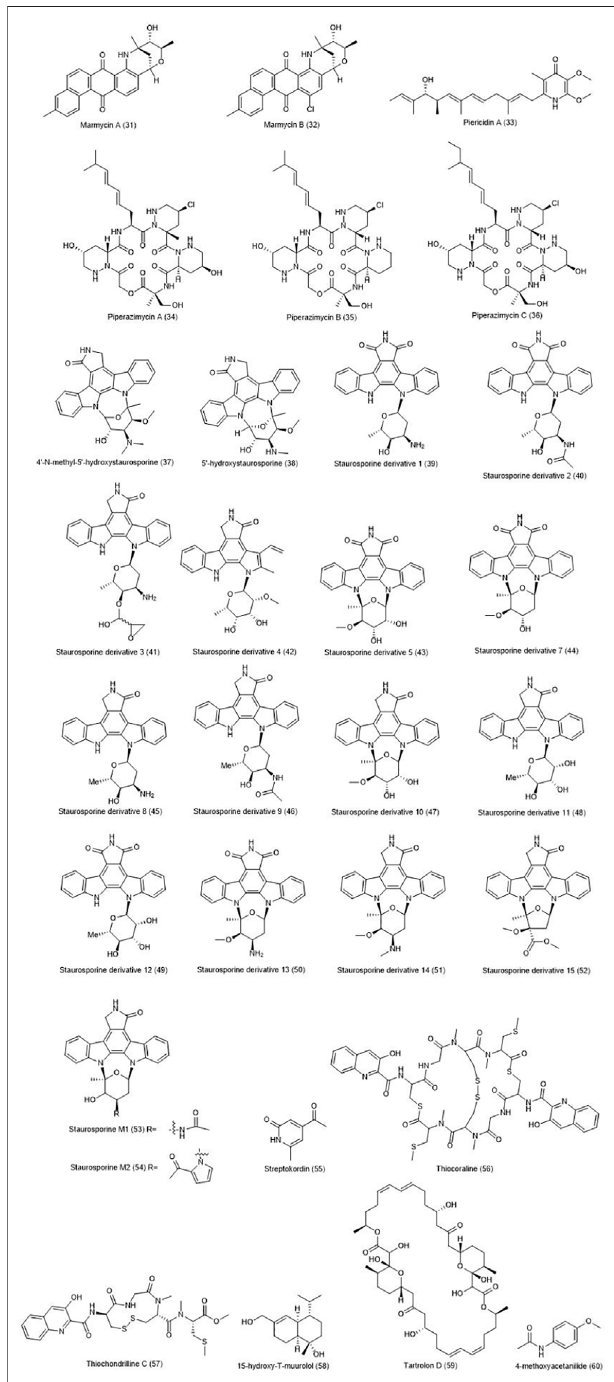
FIGURE 2 | Chemical structures of NPs 31 –